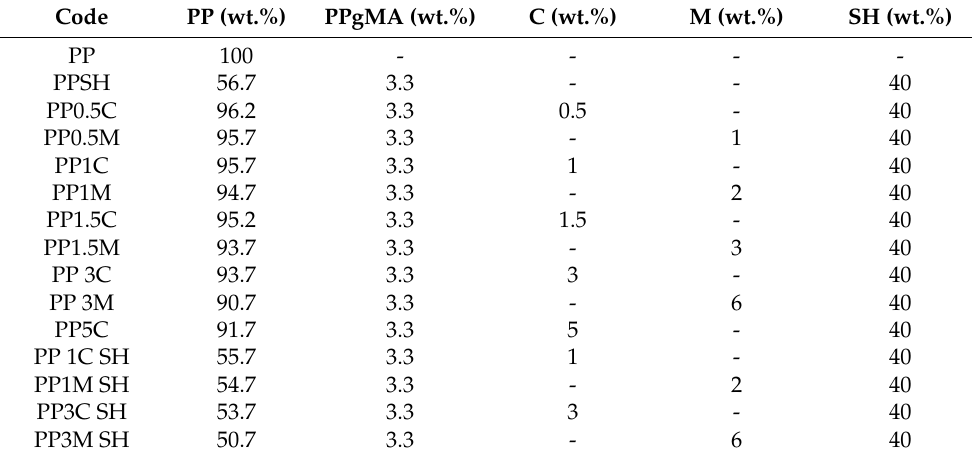
Table 1. Codes and composition of the